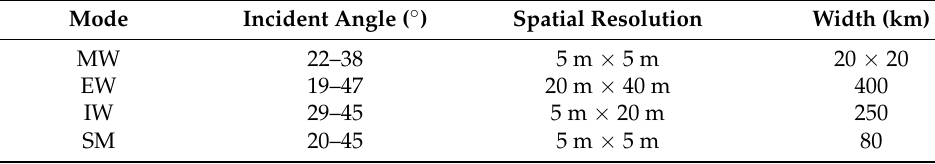
Table 1. Characteristics of the various imaging modes of S1 image.